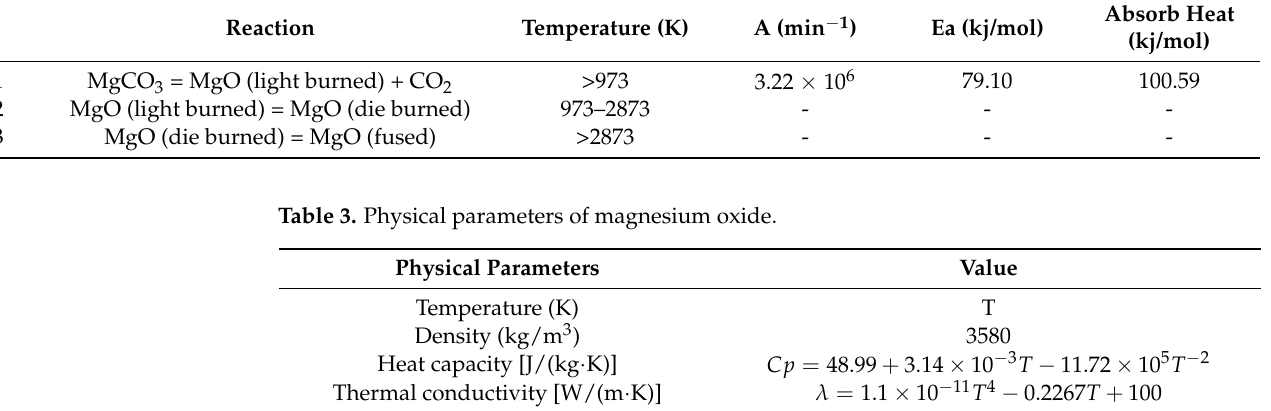
Table 2. Reduction reaction. Table 3. Physical parameters of magnesium oxide.